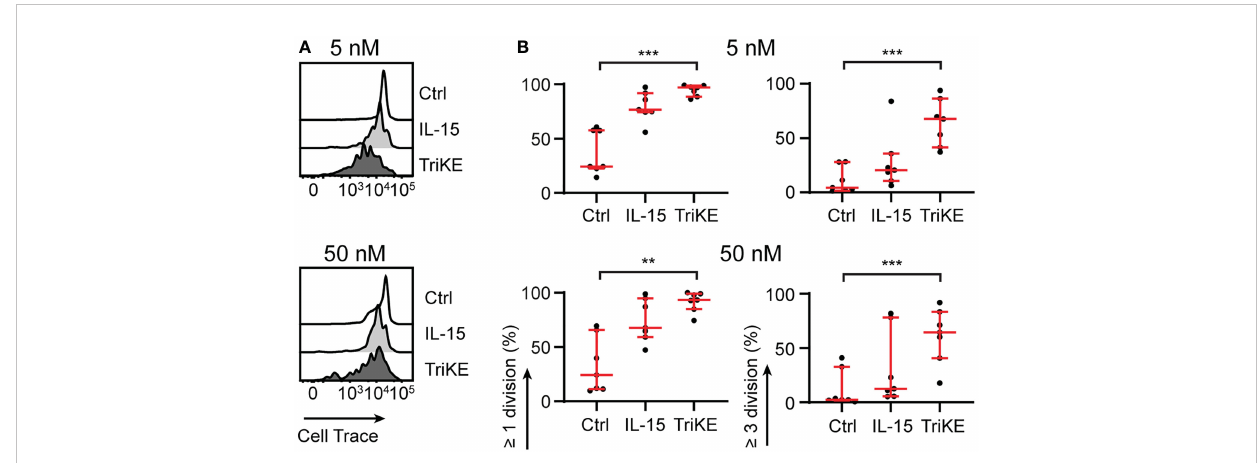
FIGURE 3 Cam1615SS1 promotes NK cell proliferation. (A, B) PBMC or puri fi ed NK cells were labelled with CellTrace Violet and cultured in media without drugs (Ctrl), with IL-15 or with cam1615SS1 (TriKE) at 5nM (top row) or 50nM (bottom row). After 7 days, the proliferation (CellTrace dye dilution) of NK cells (CD56+ CD3-) was assessed by fl ow cytometry. Representative histograms of CellTrace dye for one donor (A) are shown alongside quanti fi cation of cell division for multiple donors (B) . Ctrl, IL-15 and TriKE (n=7) analyzed by Friedman test with Dunn ’ s multiple comparisons. ** p<0.01, *** p<0.001.